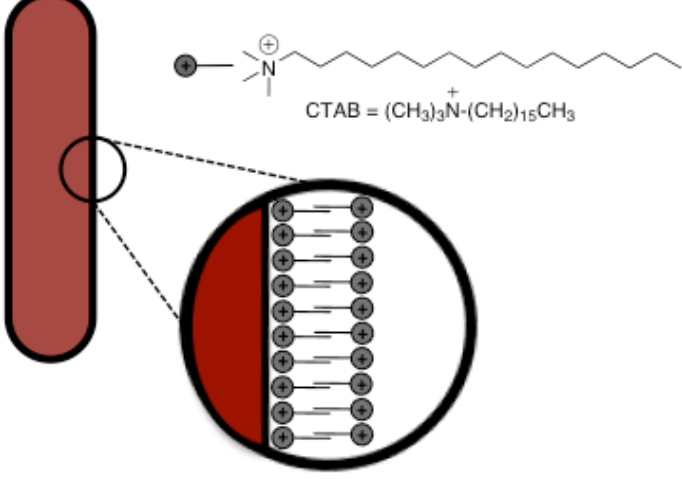
Figure 1. Schema of silver nanorod stabilization by CTAB